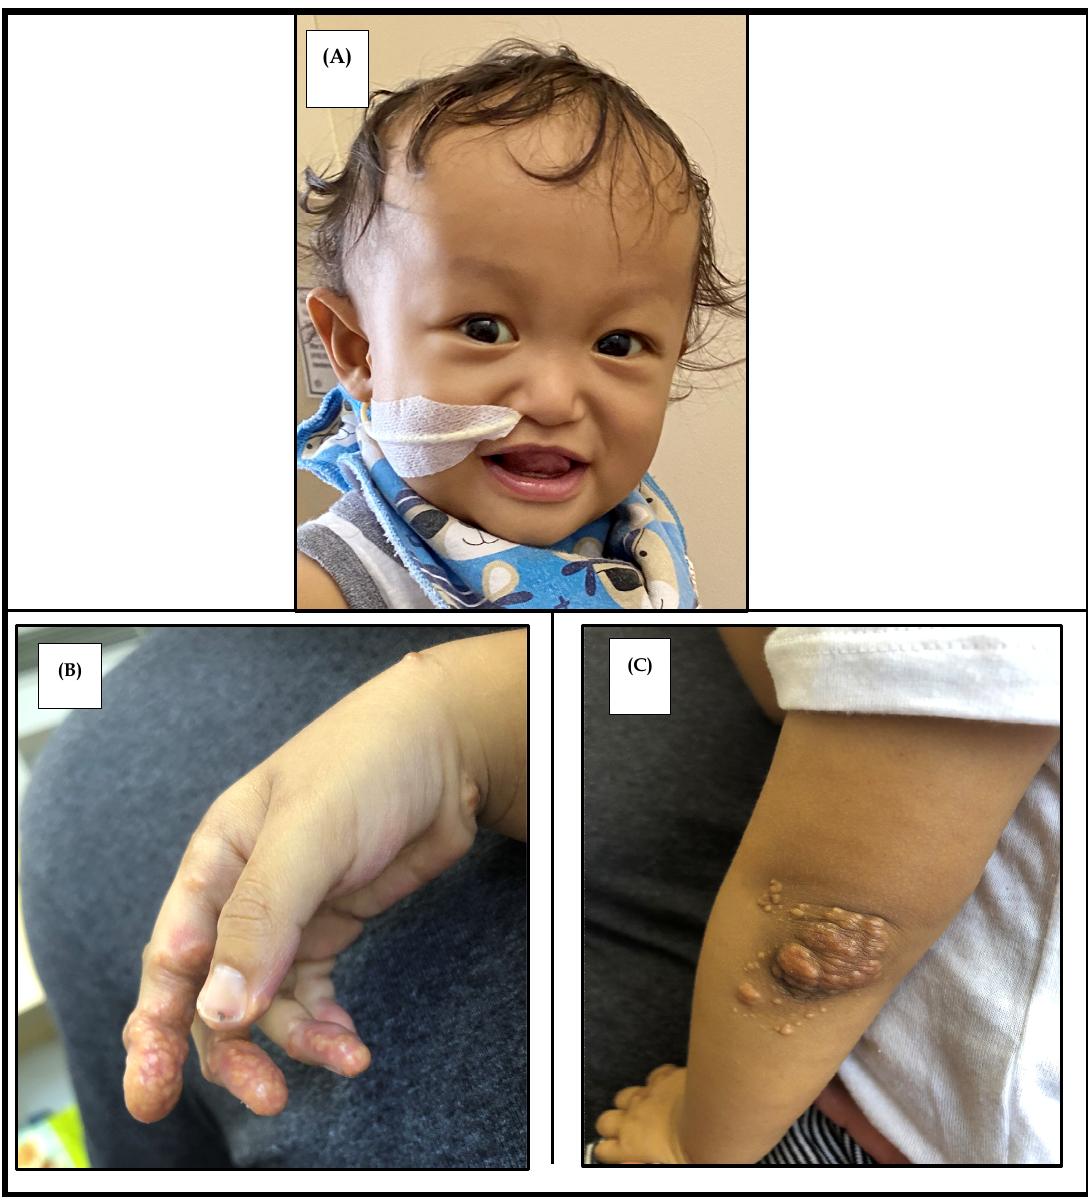
Figure 1. Clinical features of alagille syndrome. ( A ) Characteristic facies with prominent forehead, hypertelorism, straight nose with a bulbous tip, and a pointed chin. Parental consent was obtained for use of this photograph. ( B ) Cutaneous xanthoma of the palmar surface of the hand. ( C ) Xanthoma on the